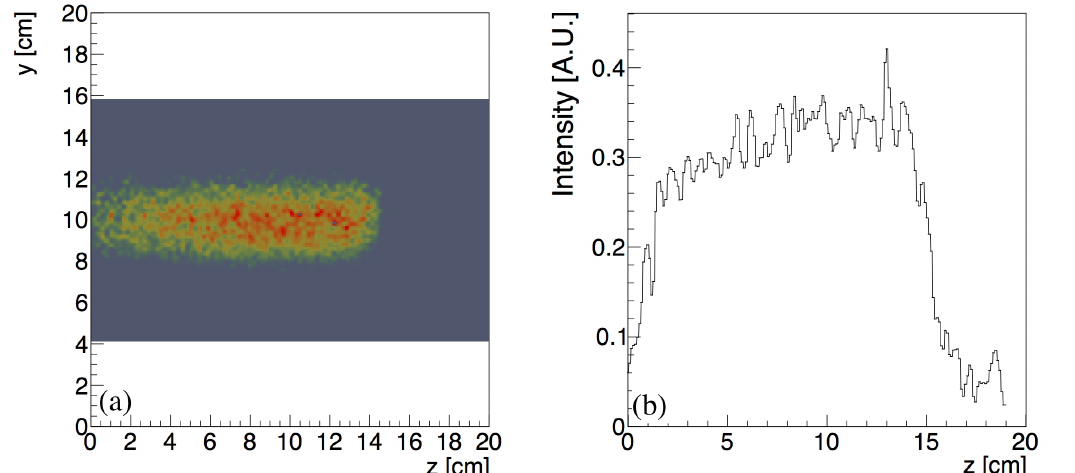
Figure 13. Reconstructed lateral profile at at y = 10 cm ( a ); and one-dimensional longitudinal profile ( b ) of the positron emitters produced by a 150 MeV proton pencil beam with approximately 2 mm spot-size and 0.3 MeV energy spread within a water target volume during beam-on